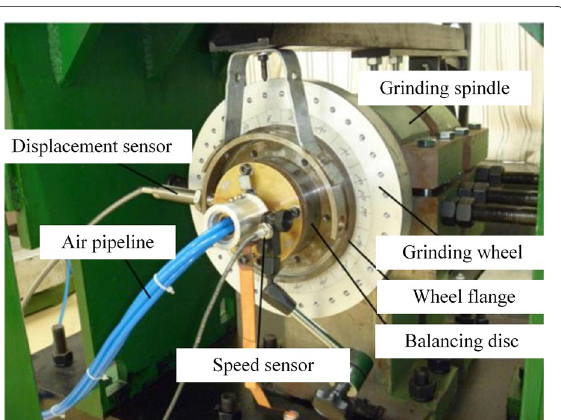
Figure 33 Experimental setup of pneumatic liquid actuator